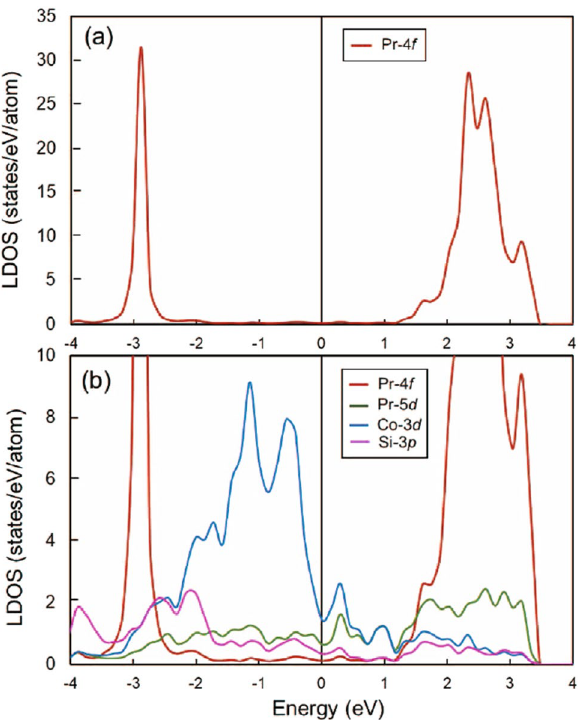
Figure 6. Local density of states (LDOS) of (a) 4 f -states of Pr atom, and (b) 4 f , 5 d states of Pr, 3 d -states of Co, 3 p -states of Si atoms in system I. The Fermi level is at E = 0